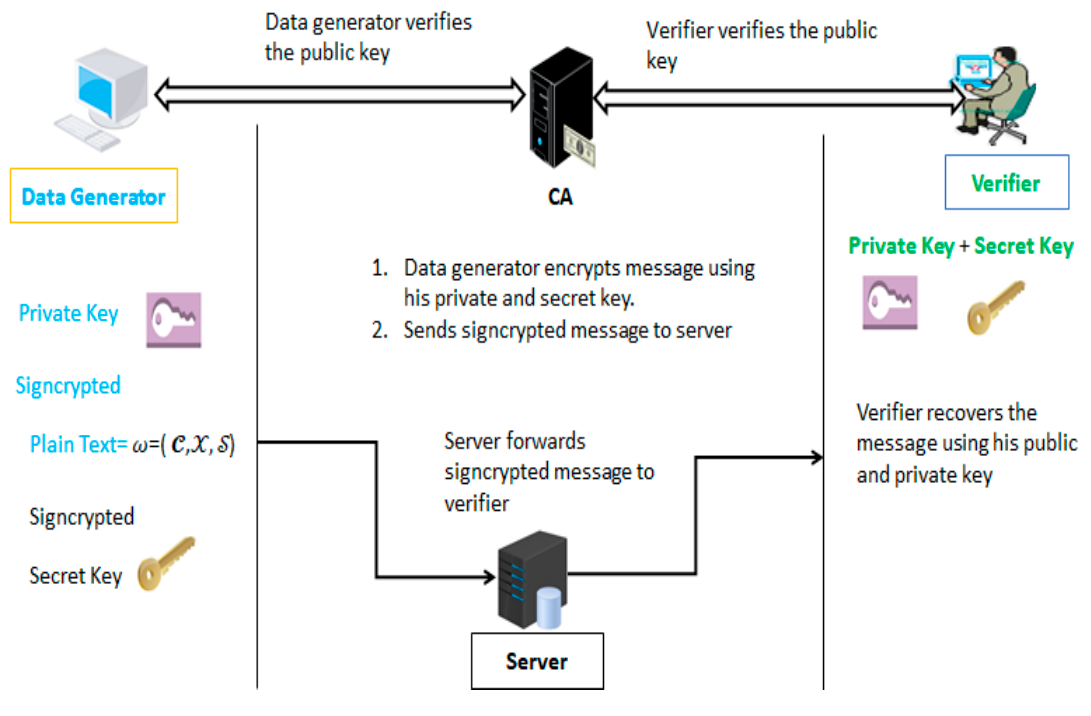
Figure 1. Flow of Proposed Model.